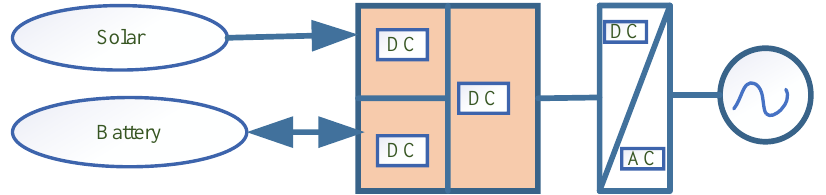
Figure 4. DC-Coupled Battery Energy Storage System Integrated PV and Grid System.